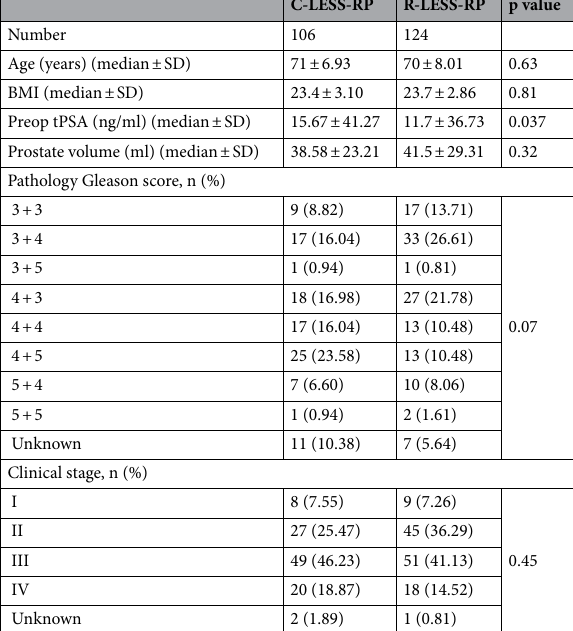
Table 1. Clinical characteristics of patients enrolled in the study ( χ 2 or Fisher’s exact test for categorical and t-test or Mann–Whitney test for continuous variables). C-LESS-RP conventional laparoendoscopic single-site radical prostatectomy, R-LESS-RP Robot-assisted laparoendoscopic single-site radical prostatectomy, BMI body mass index, SD standard